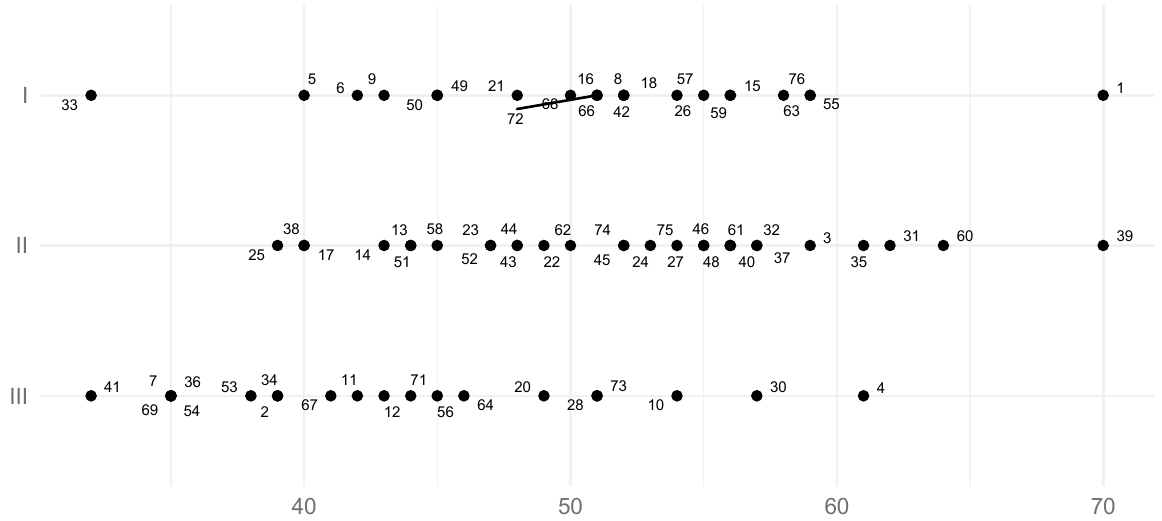
Figure 4. The distribution of the left sagittal condylar inclination (SCI) coefficient value. Numbers represent patients’ IDs. Table 2. Sagittal condylar inclination (SCI) of the right TMJ.